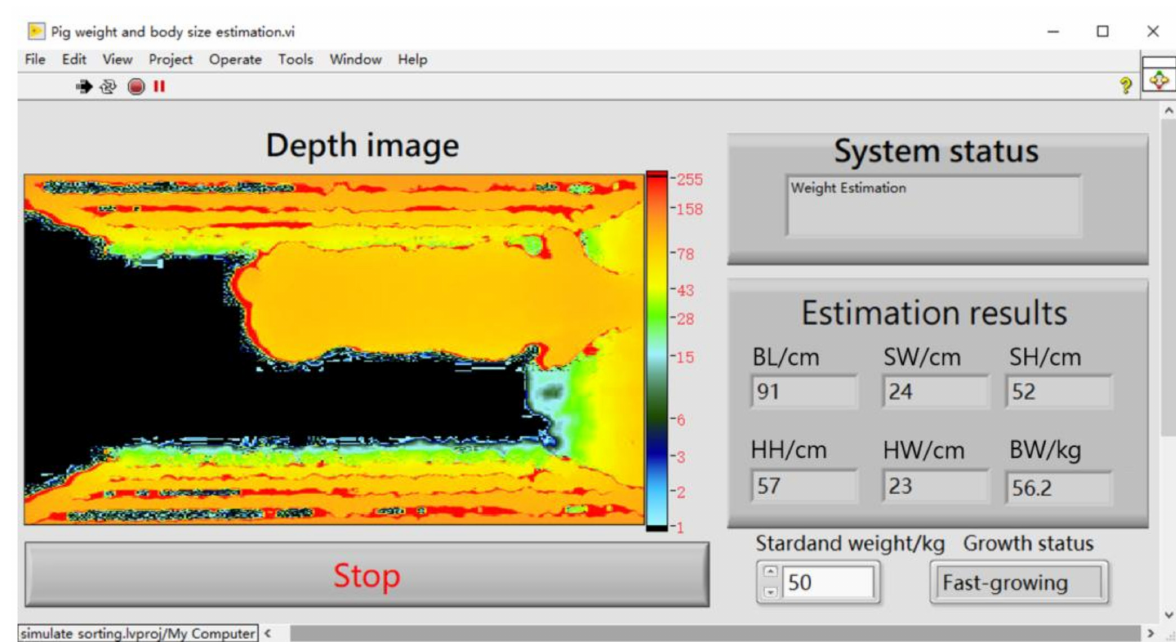
Figure 10. LabVIEW panel of the pig weight and body size estimation